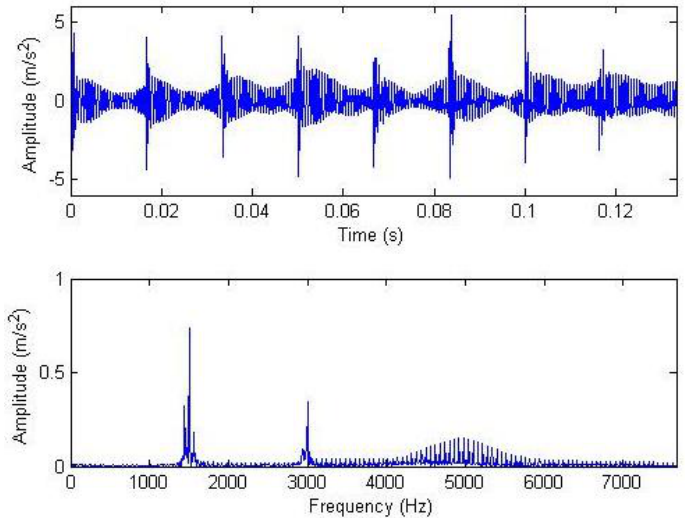
Figure 11. Waveform and frequency spectra of reconstructed signals after hard threshold (2,048).